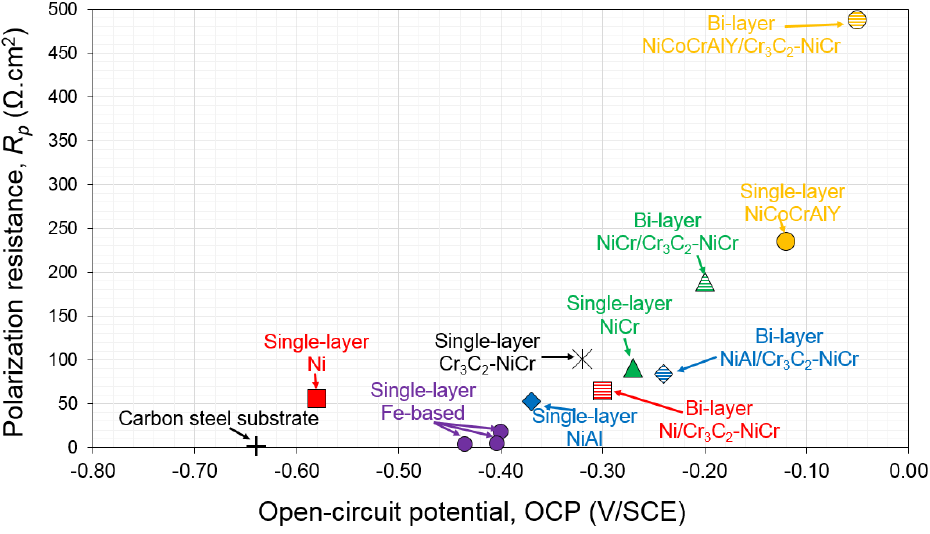
Figure 6. Polarization resistance ( R p ) vs. open-circuit potential (OCP) of various HVAF single- and bilayer coatings in 3.5 wt % NaCl solution.